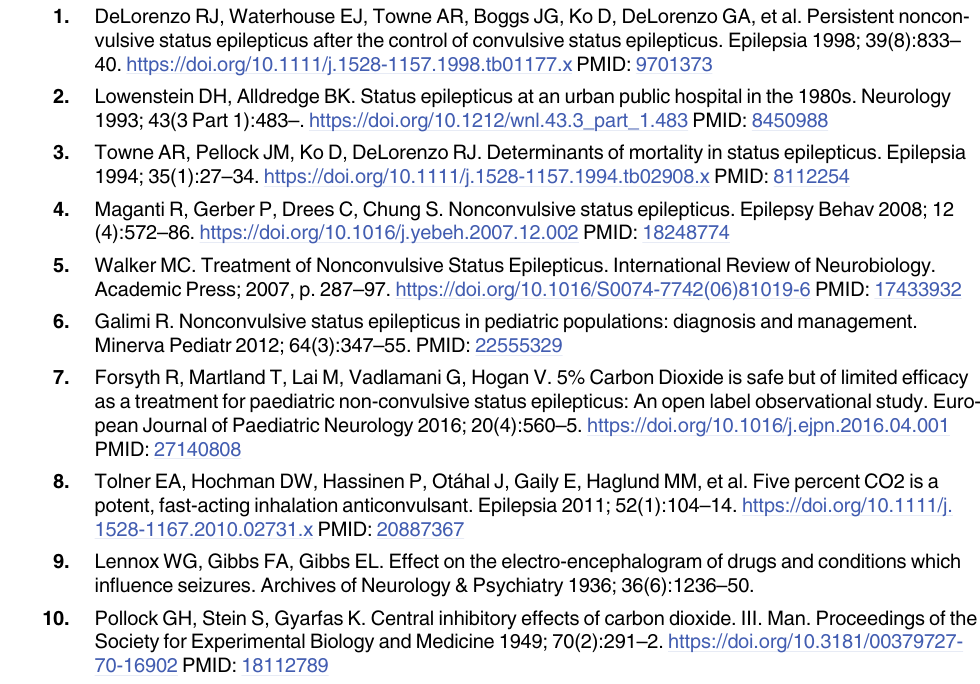
S11 Table. Effect size (Cohen’s d –values) for broadband power time series, functional con- nectivity time series, path length time series, and clustering coefficient time series. S12 Table. Permutation test p-values for broadband band power time series, functional connectivity time series, path length time series, and clustering coefficient time